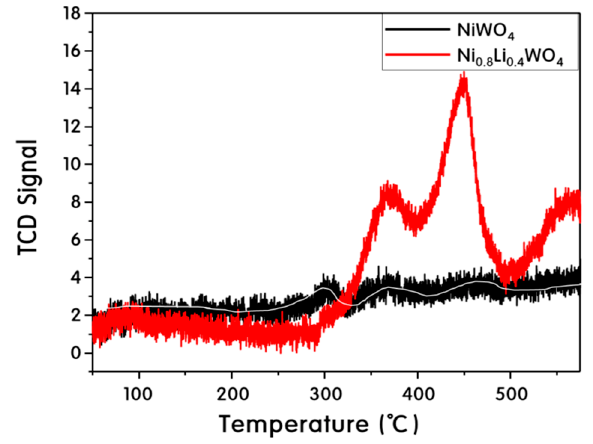
Figure 8. CO 2 gas-adsorption capacity of NiWO 4 and Ni 0.8 Li 0.4 WO 4 particles.